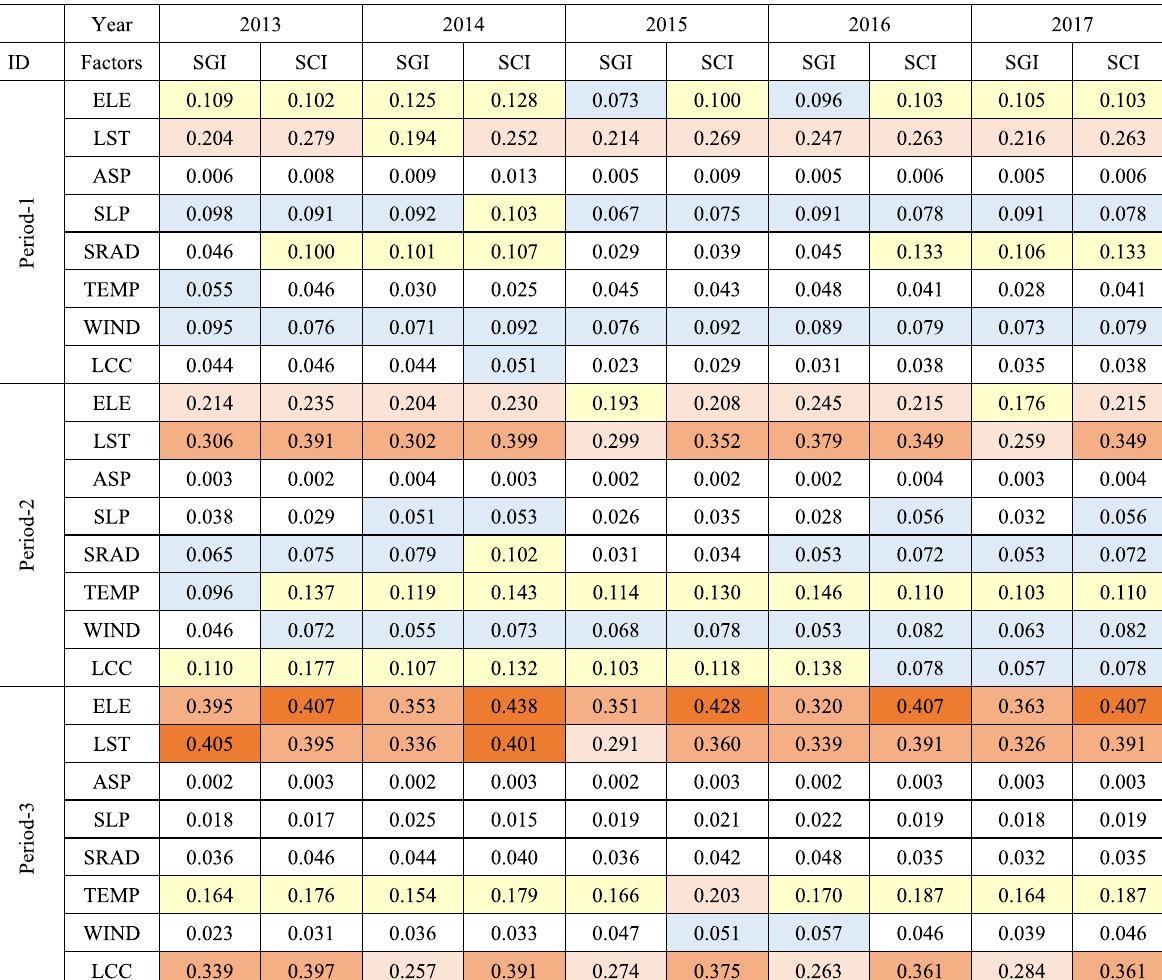
Table 3. Average Q values of the SGI and SCI in periods-1, 2 and 3 from 2013 to 2017. The warm and cool colors are used to distinguish the Q and P values. The warmer the color is, the more important it is, and vice